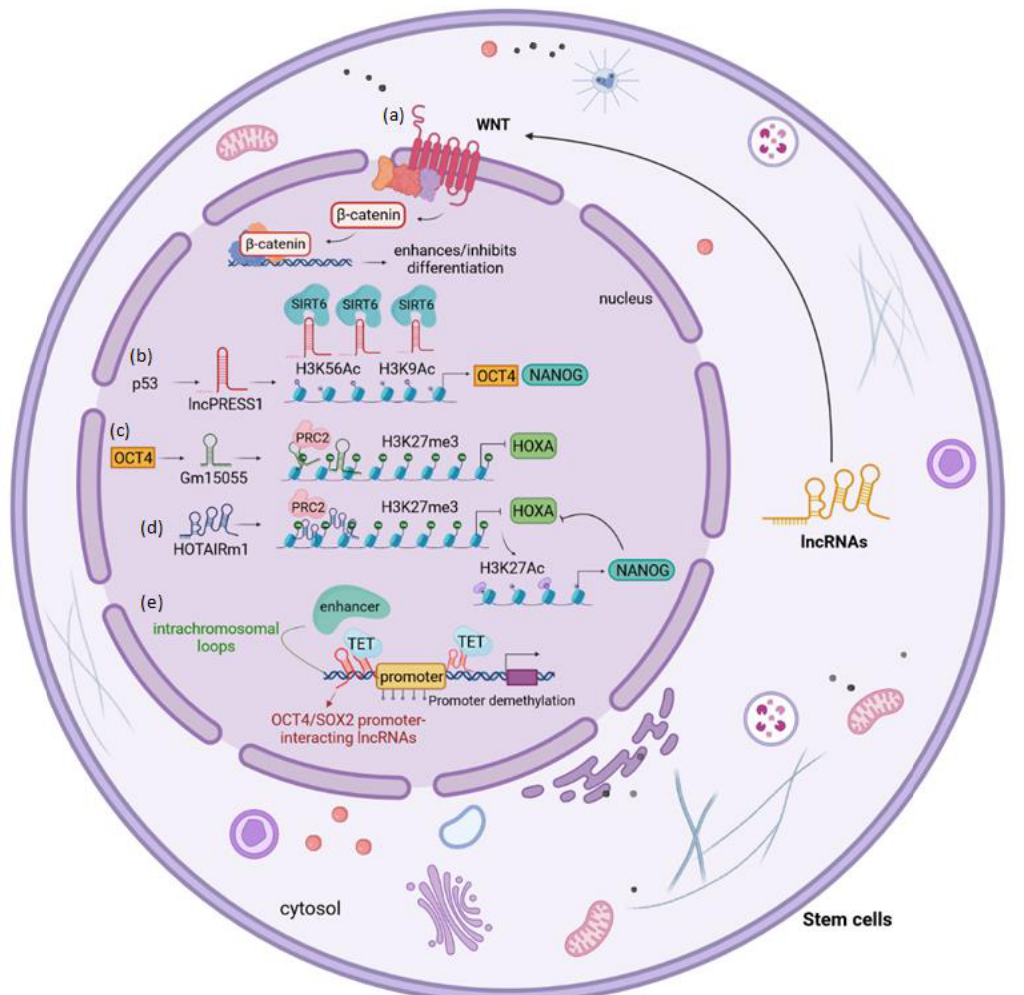
Figure 2. Regulatory mechanisms of lncRNAs in stem cells. ( a ) Several lncRNAs interact in the canonical Wnt signaling cascade and influence the expression of genes by inducing or inhibiting cell differentiation. ( b ) The p53-regulated, long non-coding PRESS1 physically interacts with SIRT6 and inhibits its attachment to chromatin, controlling a gene network that promotes the pluripotency of hESCs (human embryonic stem cells) by maintaining high levels of histone H3K56 and H3K9 acetylation in the promoters of pluripotency genes such as OCT4 and NANOG. ( c ) The lncRNA Gm15055, whose expression is influenced by OCT4, represses HoxA gene expression by recruiting PRC2 to the cluster and maintaining the H3K27me3 modification on HoxA promoters in mESCs (mouse embryonic stem cells); ( d ) The nuclear lncRNA HOTAIRm1 also regulates HoxA expression, leading to trimethylation of histone H3K27 and epigenetic silencing of the gene; furthermore, it promotes the acetylation of H3K27 in the enhancer site of the NANOG gene by upregulating its expression and inhibiting HoxA, which creates a reciprocal regulatory loop that increases the stemness effect. ( e ) Some lncRNAs enhance epigenetic reprogramming by coordinating intrachromosomal looping and by recruiting the TET2 demethylase, promoting DNA demethylation at the OCT4 and SOX2 promoters.